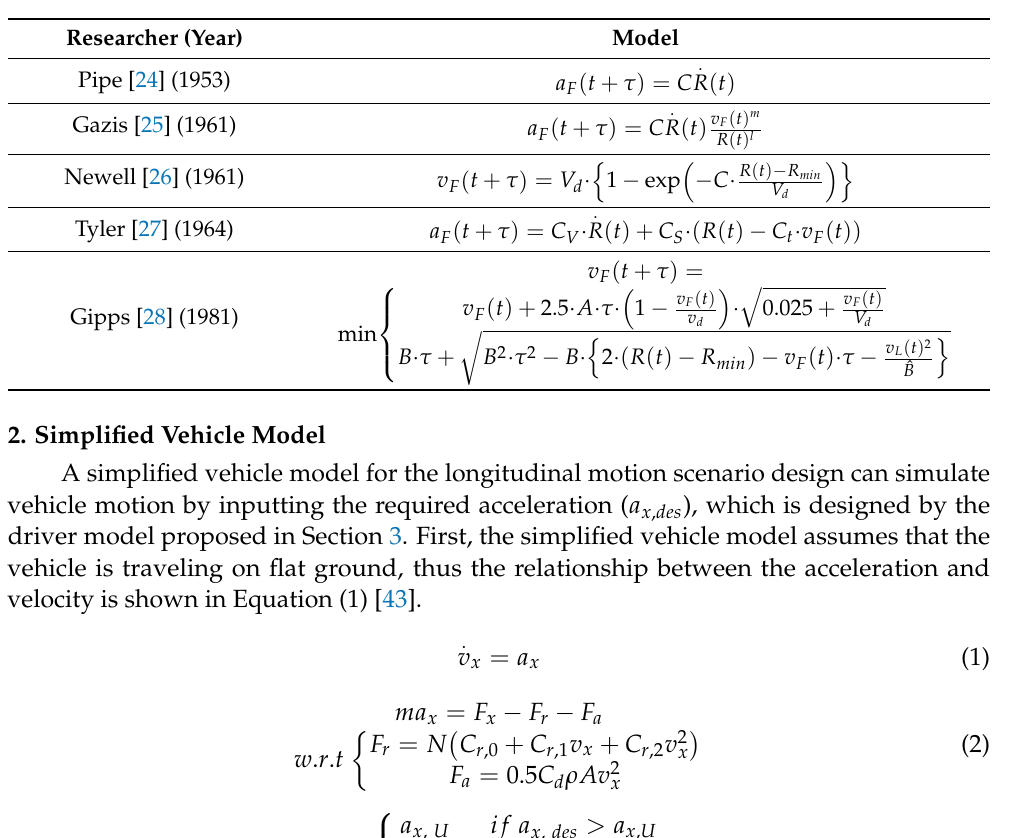
Table 1. Deterministic classical car-following